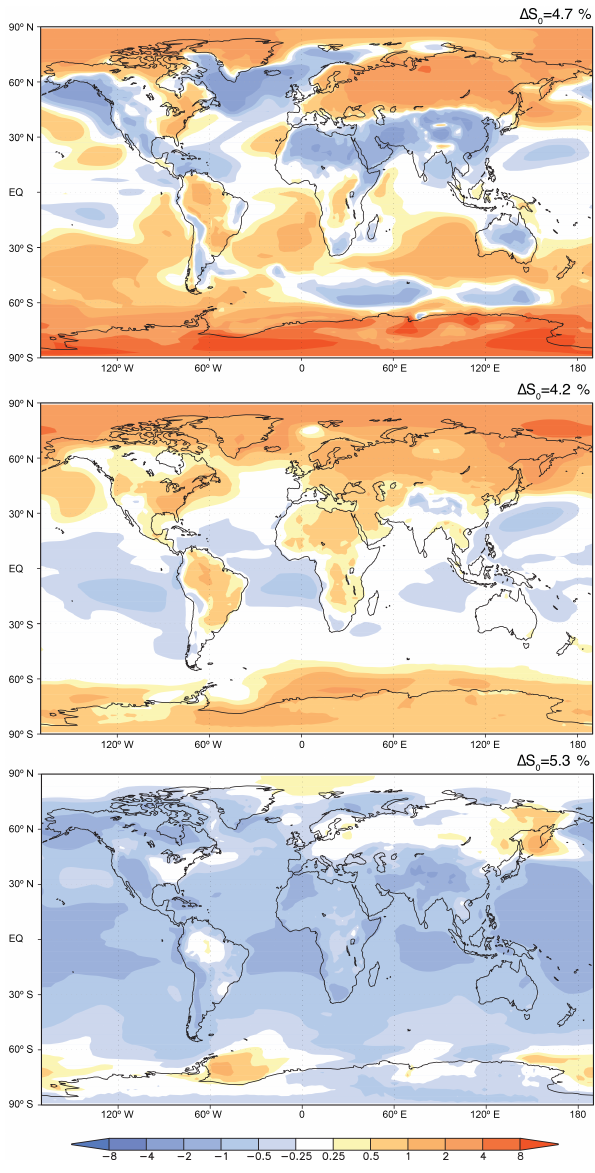
Figure 1. These three panels show that the “canonical” temperature response to offsetting global mean temperature increases from CO 2 (an abrupt quadrupling of the CO 2 concentration from its prein- dustrial value) with total solar irradiance reduction (top panel; e.g., Govindasamy and Caldeira, 2000; Kravitz et al., 2013a) still in- volves a degree of freedom, in that the resulting temperature pat- tern depends upon the amount of solar reduction. The middle panel shows the temperature response if total solar irradiance is reduced such that the mean tropical temperature does not represent an over- cooling. The bottom panel shows the temperature response if total solar irradiance is reduced such that the mean polar temperature does not represent an undercooling. Values above each panel in- dicate the percentage reduction in total solar irradiance. All simu- lations were conducted with CESM and represent an average over years 11–20 of